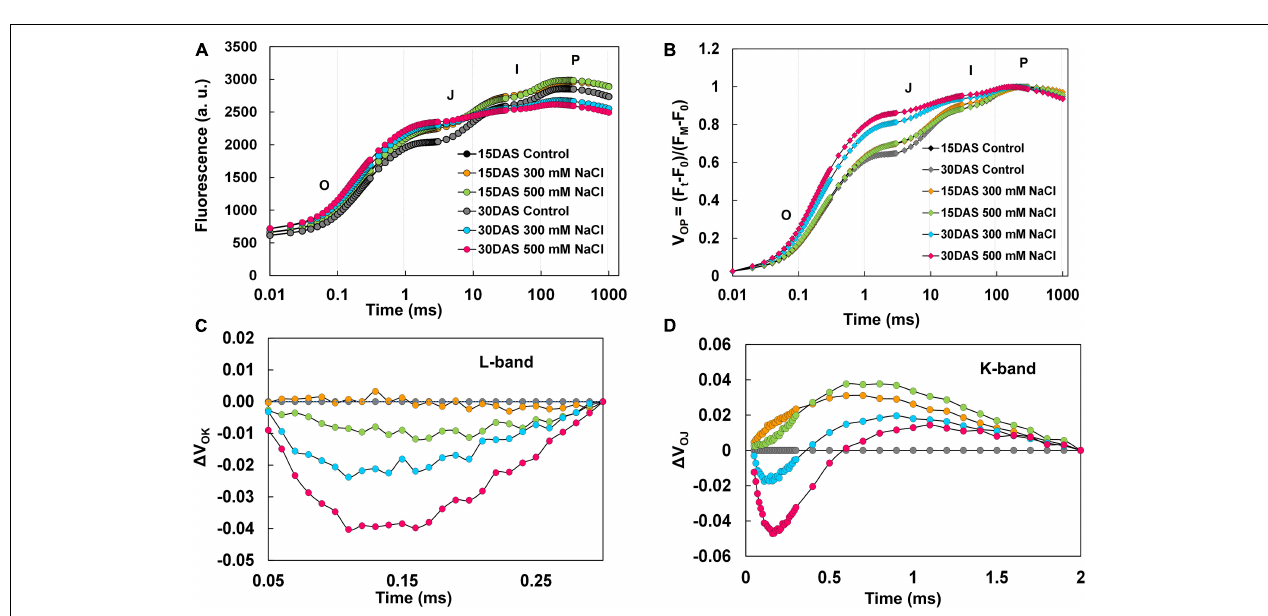
FIGURE 4 | Radar plot depicting salt stress-induced changes in Chl a fluorescence transient parameters in Pongamia grown under 300 and 500 mM NaCl concentration for (A) 15 and (B) 30 day. All variables were deduced from the OJIP-test analysis. Data are mean ± SD ( n = 4).